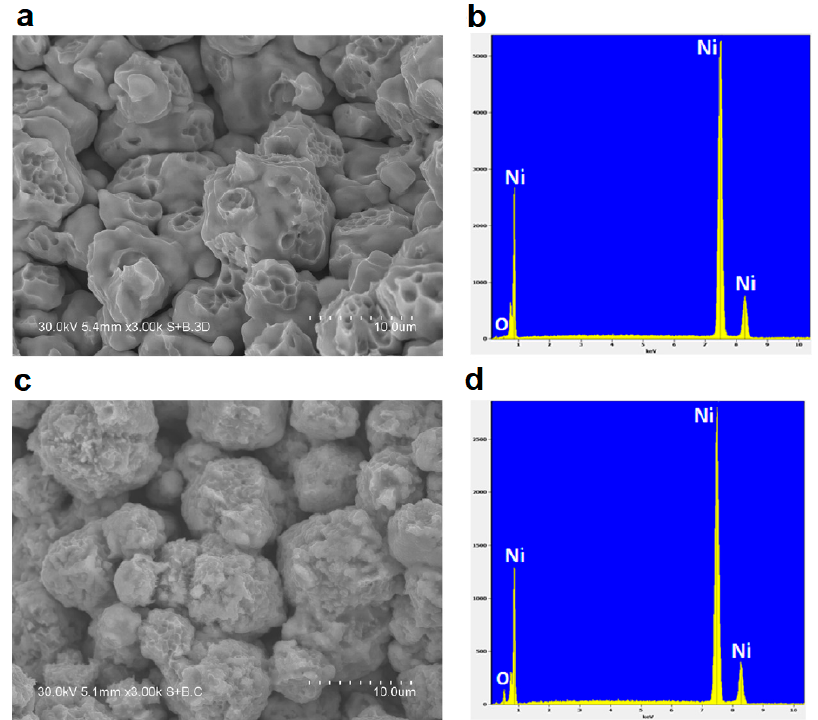
Figure 5. Fracture surface ( a , c ) and results of the energy-dispersive spectroscopy analysis ( b , d ) of nickel compacts consolidated by SPS from a partially oxidized nickel powder, ( a , b ) SPS in contact with graphite foil, ( c , d ) SPS in contact with copper foil. Reprinted from Dudina & Bokhonov [25], Copyright (2016), with permission from Elsevier.